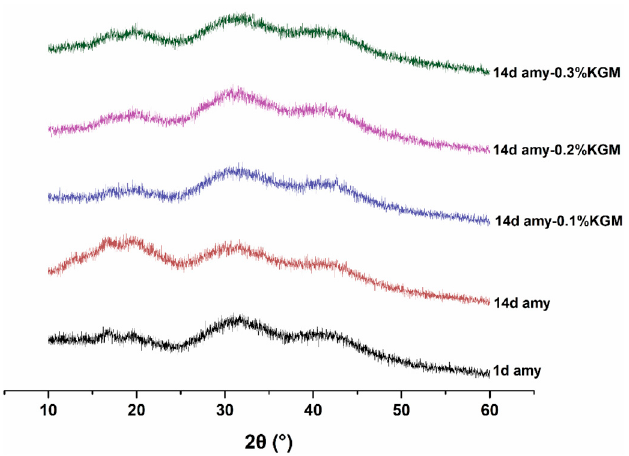
Figure 8. XRD curves of amylose–KGM mixtures at different storage